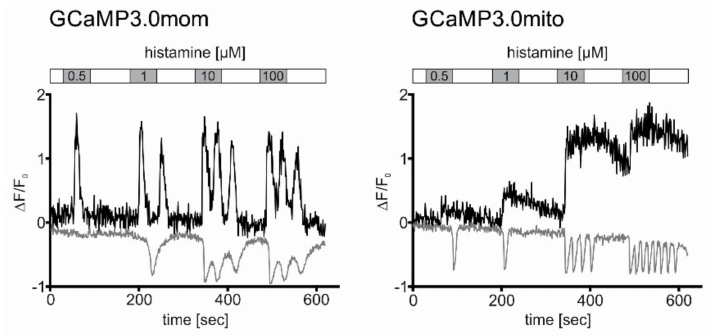
Figure 7. Registration of histamine-evoked Ca 2+ signals in cells expressing mitochondria- targeted GCaMP3.0 versions and loaded with Fura-2. Cells constitutively expressing GCaMP3.0mom or GCaMP3.0mito were loaded with the Ca 2+ sensitive dye Fura-2. Samples were superfused with extracellular solution (ES: 120 mM NaCl, 5 mM KCl, 2 mM MgCl 2 , 2 mM CaCl 2 , 10 mM HEPES, 10 mM glucose, pH 7.4; white bar) containing increasing histamine concentrations (0.5–100 µ M; grey bars) for 60 s. Between stimulations, cells were superfused with histamine-free ES for 90 s. Ca 2+ -dependent fluorescence signals in individual cells were registered. Two-photon excitation (920 nm) was used to register Ca 2+ -dependent fluorescence emission from GCaMP3.0mom or GCaMP3.0mito during the stimulation protocol with histamine (black traces). Thereafter, the same cell was excited at (760 nm) to monitor Fura-2 responses using the same stimulation regime (grey traces). The change in fluorescence ( ∆ F = F-F 0 ) was normalized against the basal fluorescence (F 0 ). Normalized values ( ∆ F/F 0 ) were plotted against the time (s). Binding of Ca 2+ ions to GCaMP3.0 sensors causes an increase in fluorescence emission. Binding of Ca 2+ ions to Fura-2 causes a decrease in fluorescence